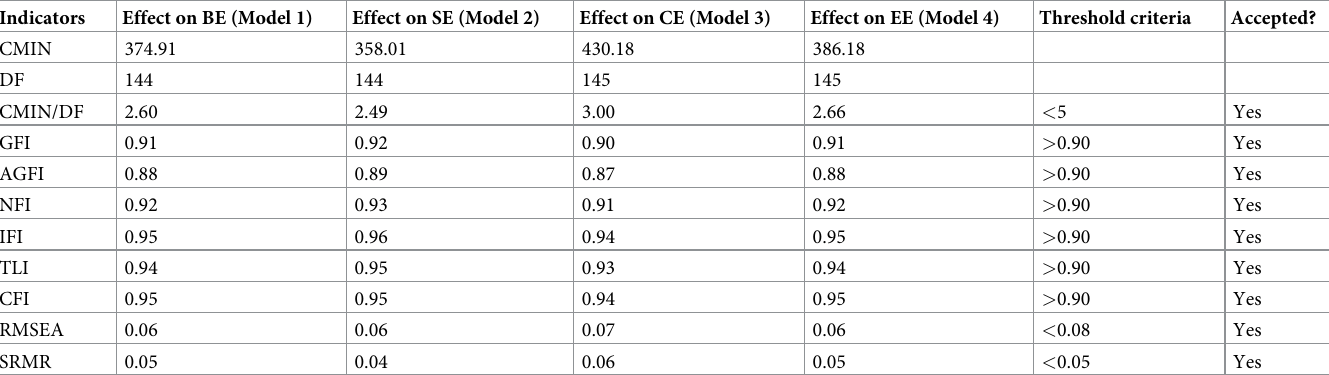
Table 3. Model fit indices in SEM (n = 402).